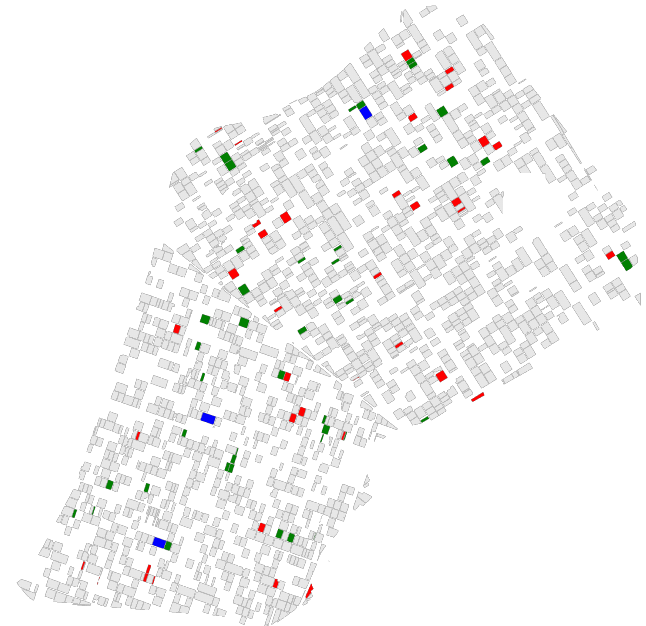
Figure 13. Maps of diagnosed Sector BXII crop